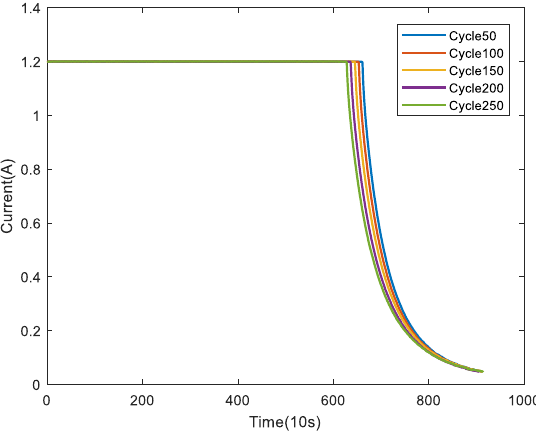
Figure 2. Charging – time curves at different cycles. Figure 2. Charging–time curves at different